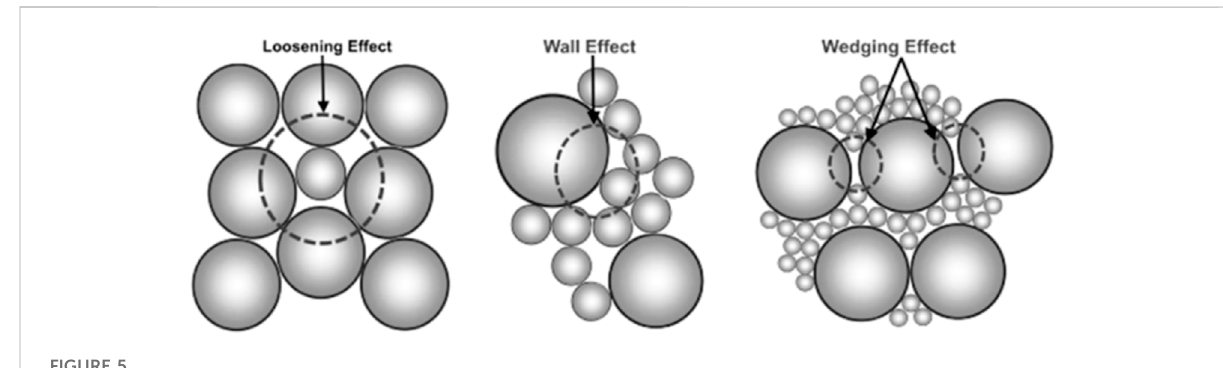
FIGURE 5 Particle packing mechanism in the UHPC (Abu-Lebdeh et al.,